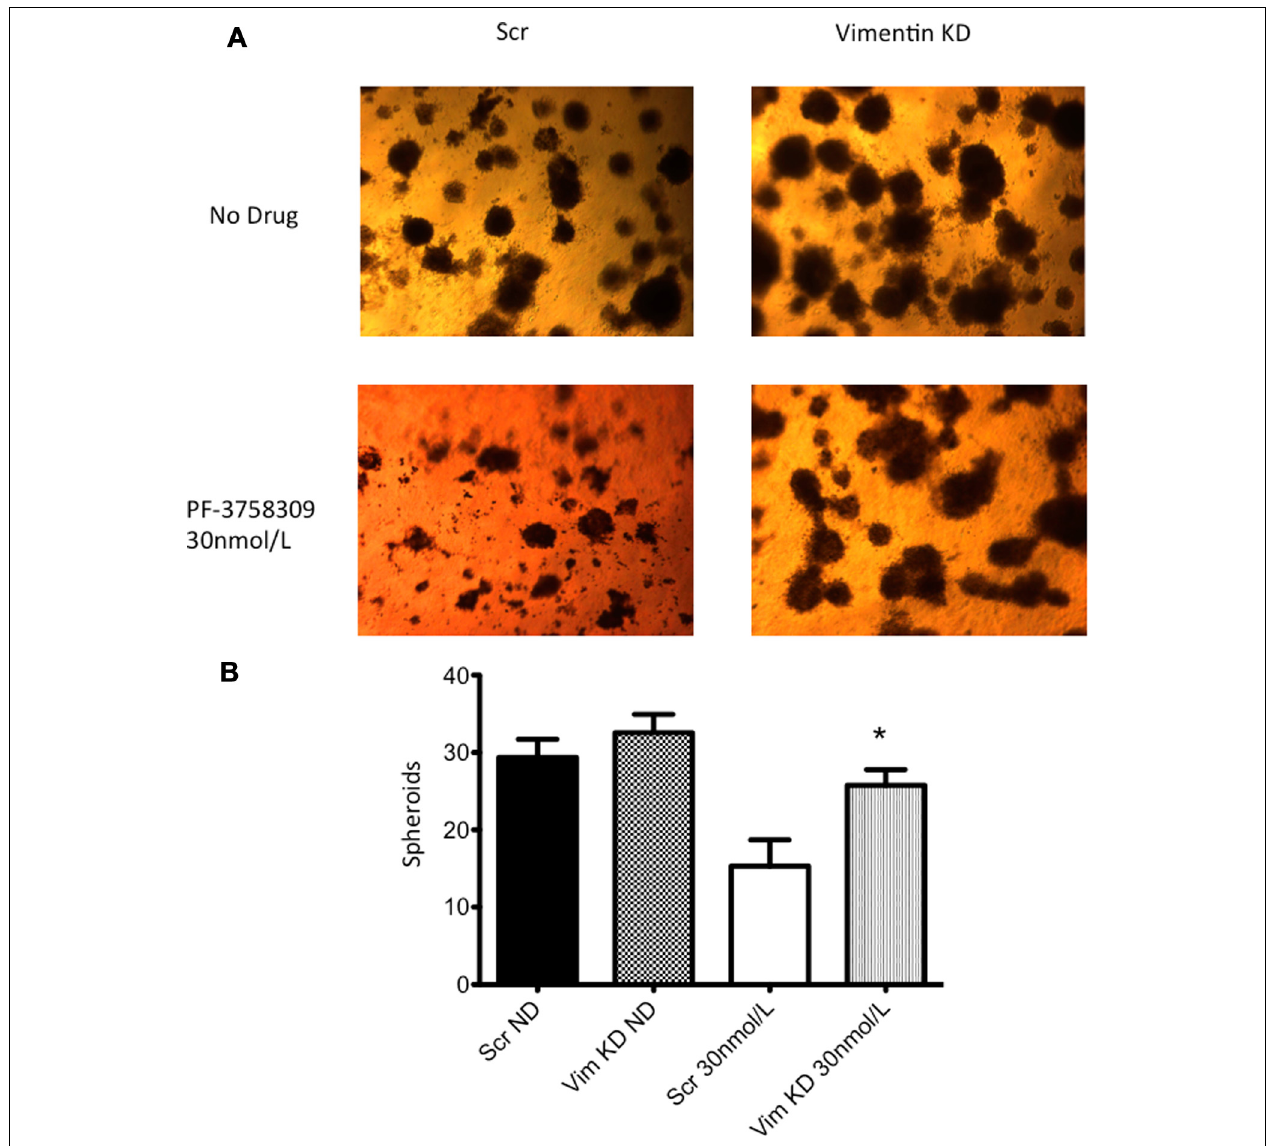
FIGURE 8 |Three-dimensional (3D) culture of RKO vimentin knockdown. (A) The transfected cell lines were plated in 3D culture in matrigel to observe spheroid formation and treated with 30 nmol/L of PF-3758309 for 21 days.